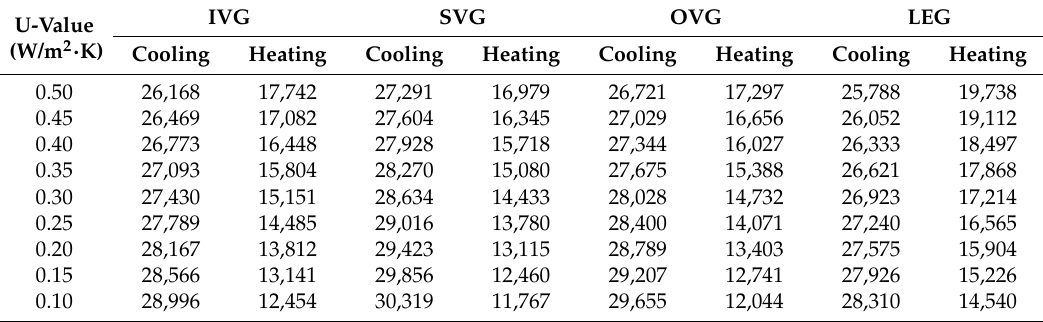
Table 6. Cooling and heating energy due to insulation enhancement in office buildings [kWh].